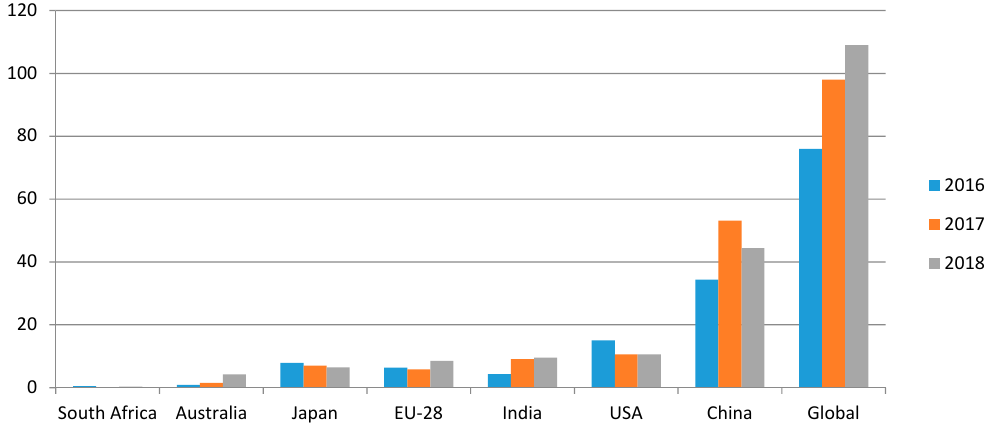
Figure 3. PV capacity (GW) installed globally in recent years [36].